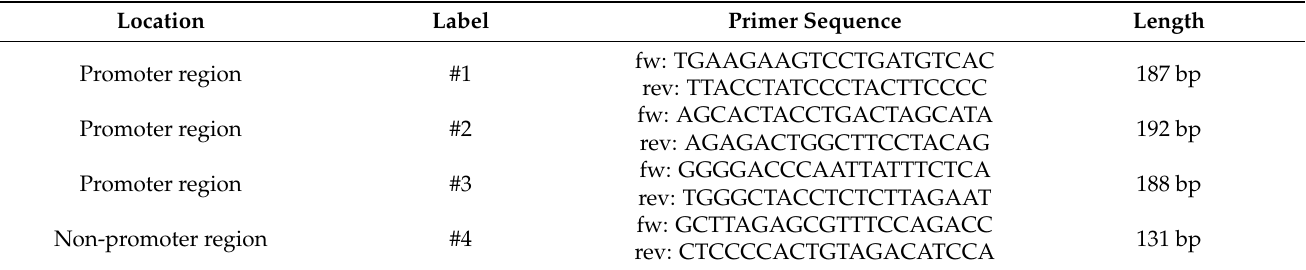
Table 2. The percentage input method was used to normalize the DNA content [46]. The IgG controls were subtracted from the H3K27me3-specific samples. Table 2. qPCR primer pairs located in the human IL10 in promoter regions (#1, #2 and #3) and a non-promoter region (#4) indicated in the 5 (cid:48) -3 (cid:48) direction. bp, base pairs; fw, forward; Length, amplicon length; rev,